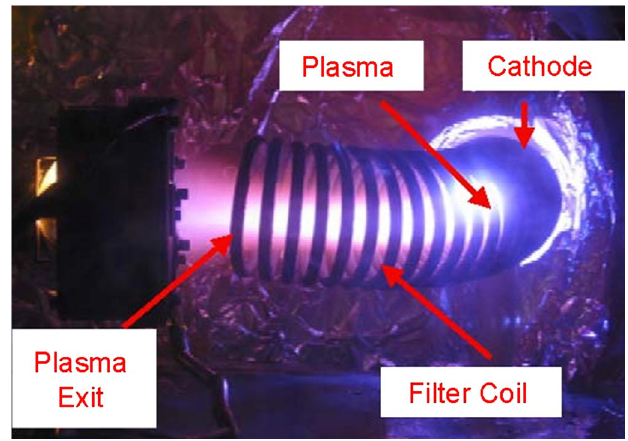
FIG. 1. (Color) Photograph of the FCAPS in operation on a test stand, before installation on the NDCX device